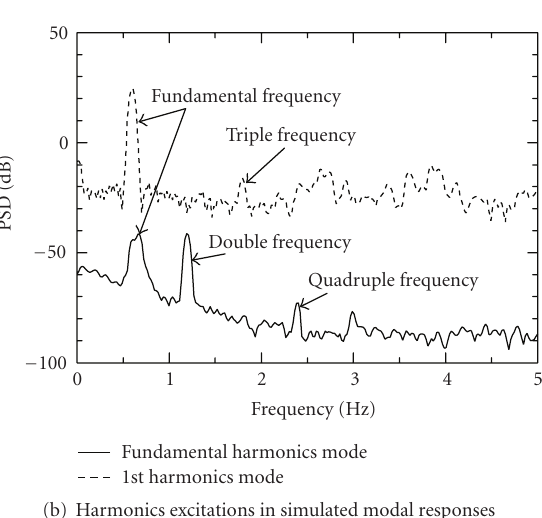
Figure 11: Harmonics excitations under regional limit cycle oscillations.